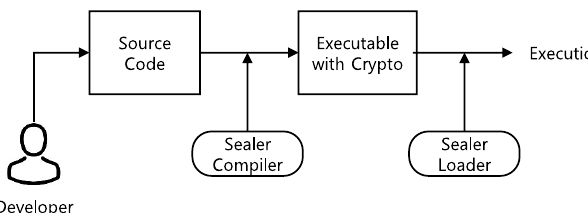
Figure 2. Development process in Sealer for data isolation.